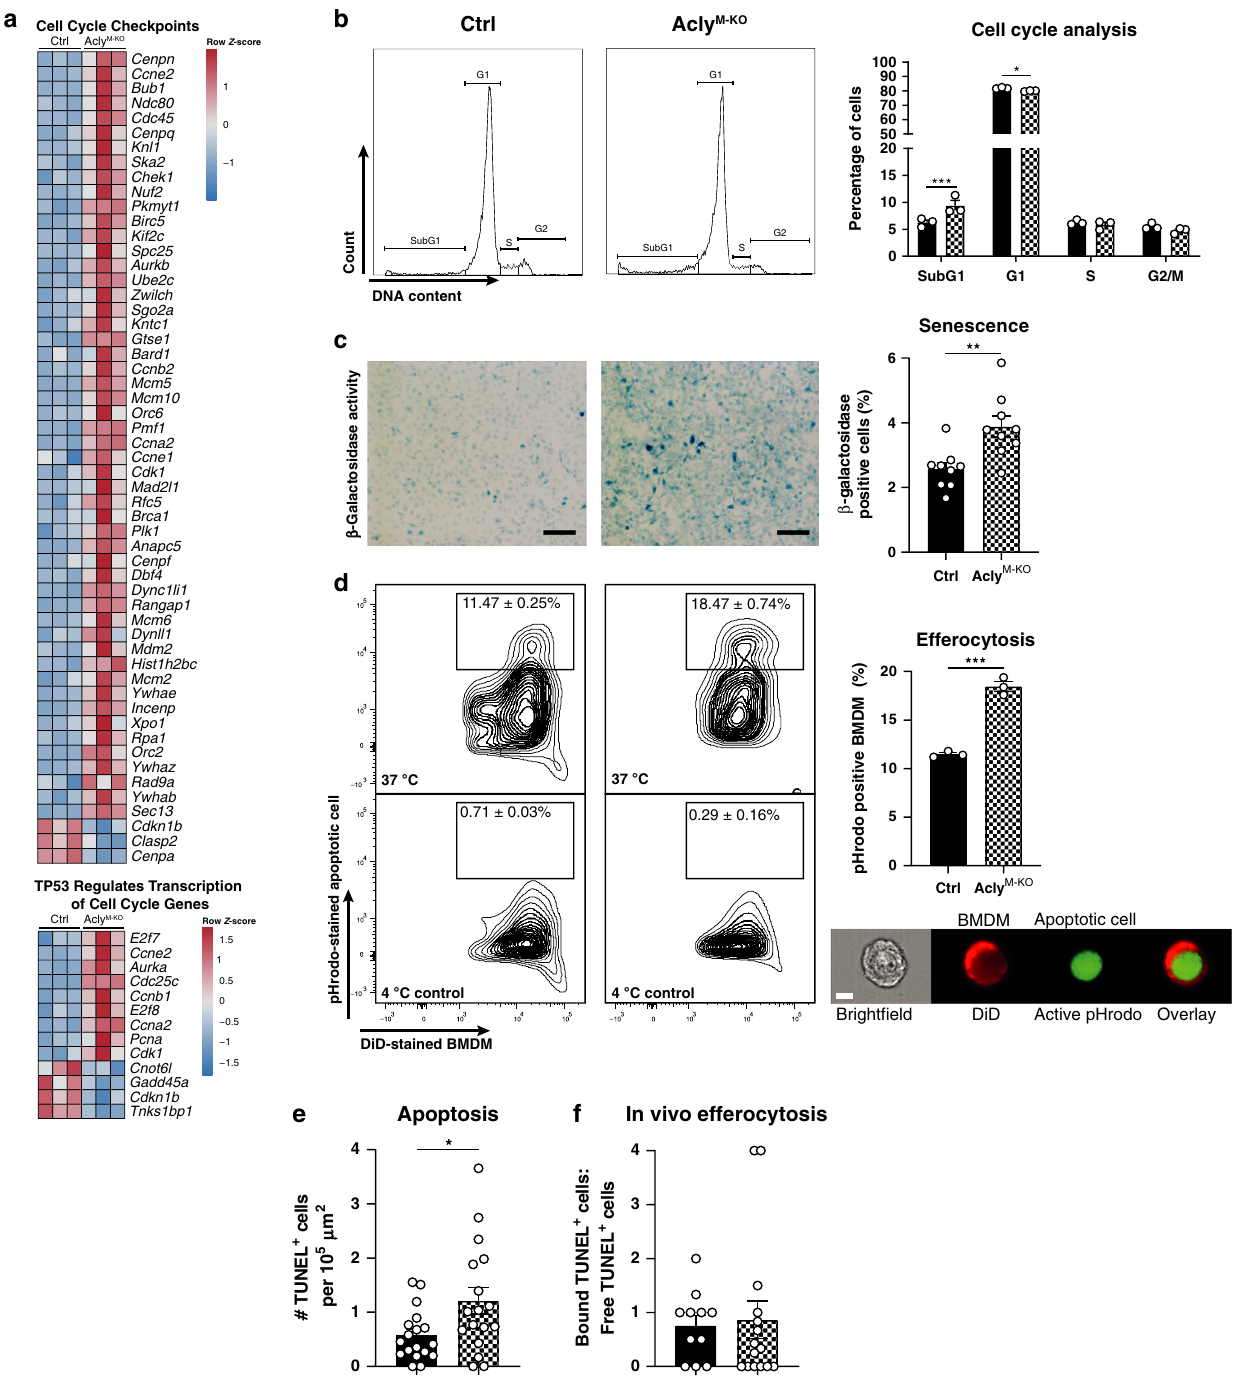
Fig. 8 Deletion of Acly results in increased apoptosis, growth arrest, and more-ef fi cient efferocytosis. a Expression of genes associated with indicated reactome pathways. b Flow cytometric analysis of control and Acly M-KO macrophages stained with propidium iodide to asses cell cycle distribution. *** P